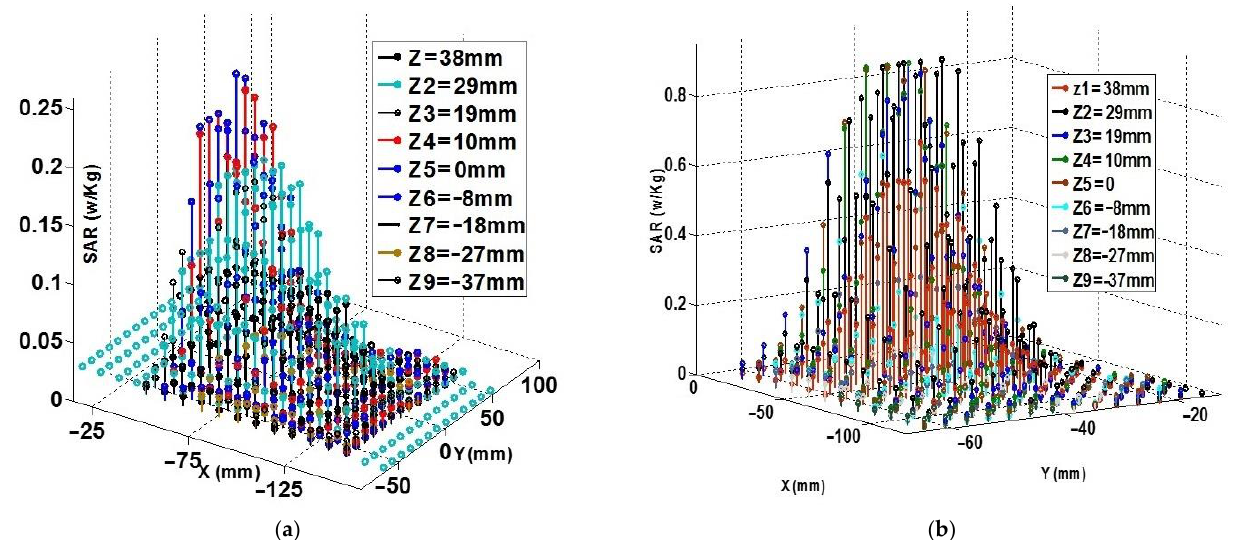
Figure 9. Simulation results of SAR distribution ( a ) with MD-AMC board, ( b ) without MD-AMC board.